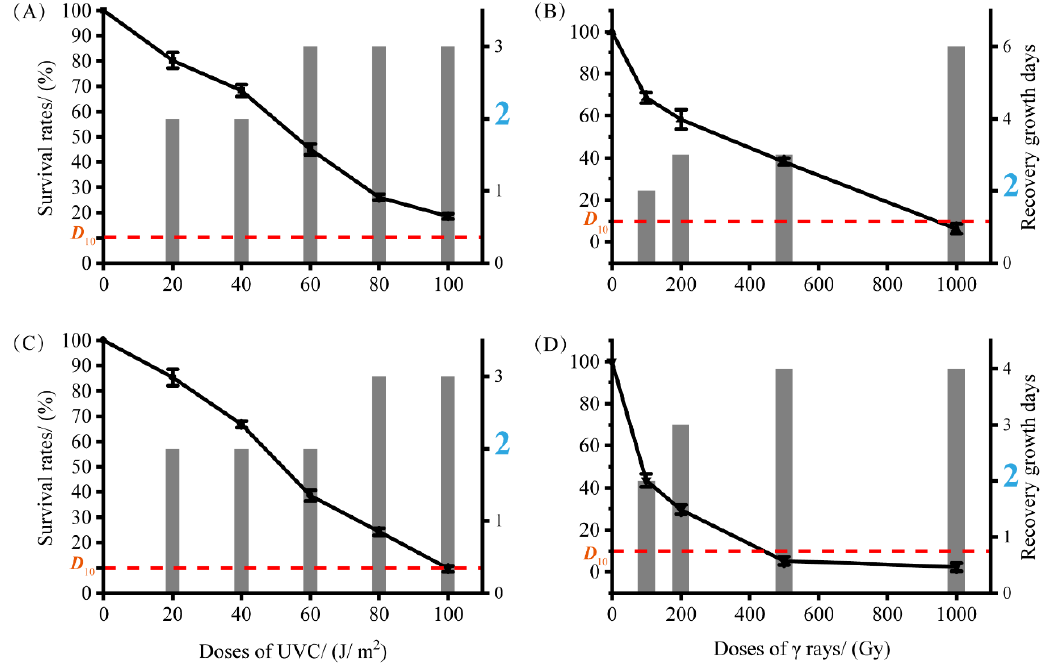
Figure 4. The survival rates of strains S5-59 T and S8-45 T after irradiation with different doses of UVC and γ rays’ radiation. D 10 –values are displayed by the red dash line; the blue numbers on the right y -axis of each image represent the normal growth time of the strains without irradiation. ( A ) Survival rates of S5-59 T after irradiation by different doses of UV-C; ( B ) survival rates of S5-59 T after irradiation by different doses of γ rays; ( C ) survival rates of S8-45 T after irradiation by different doses of UV-C; and ( D ) survival rates of S8-45 T after irradiation by different doses of γ rays.